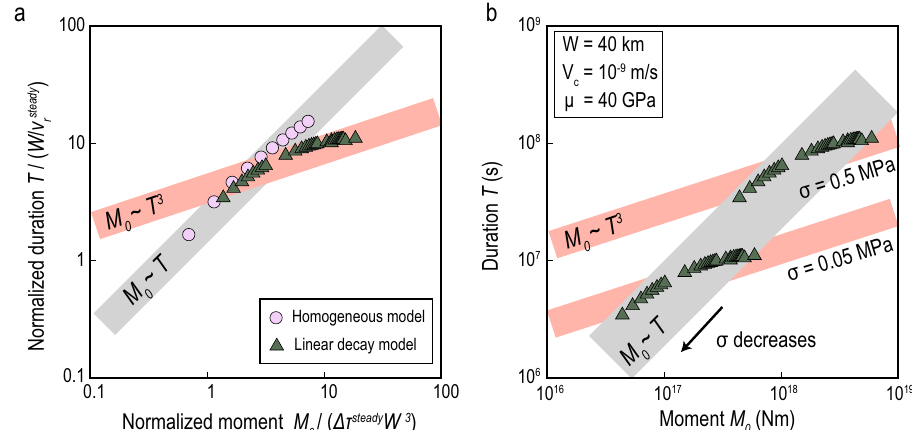
Fig.4|Moment-durationscalingofSSEscontrolledbyheterogeneities.a Linear and cubicmoment-duration scaling relations based onmodelswith homogeneous shearstress(pinkcircles)andlinearlydecayingshearstress(greentriangles). Δ τ steady and v steady r are the critical stress drop and rupture speed for steady SSEs,